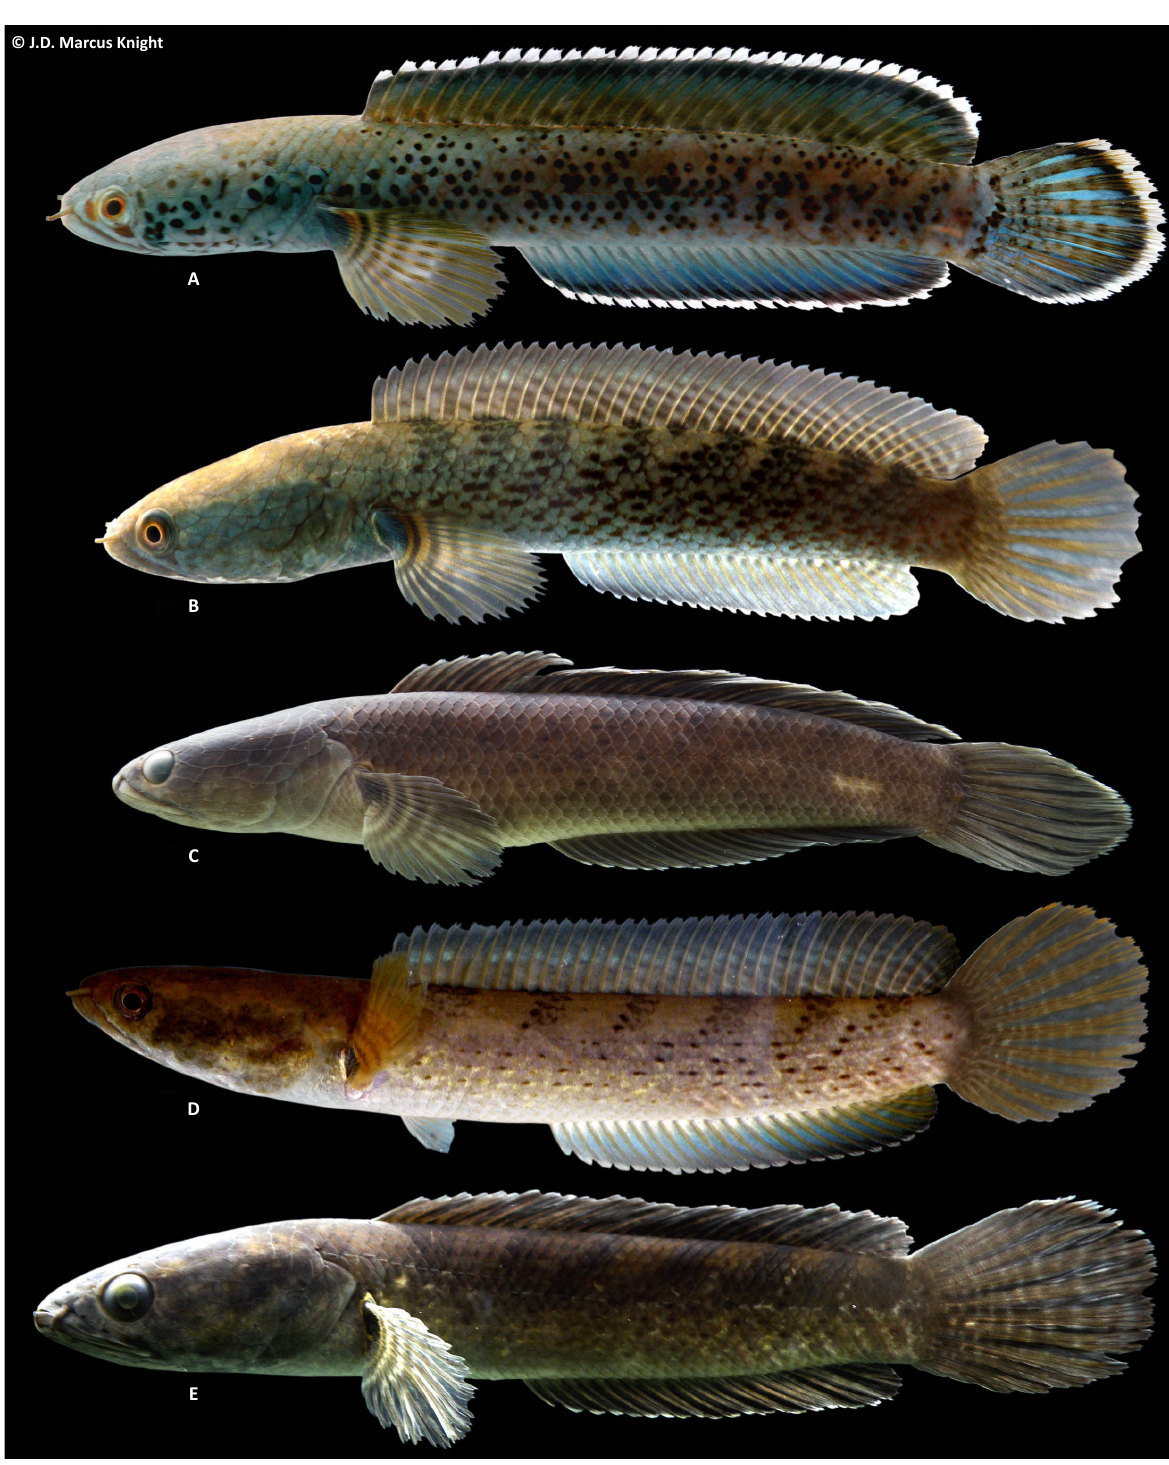
Image 2. Channa pardalis : A, paratype, ZSI/SRC F 8954, 139.3mm SL, showing live colouration, West Khasi Hills, Meghalaya. C. stewartii : MKC 100, Cachar, Assam, B, 109.2mm SL, showing live colouration, C, 128.6mm SL, showing colouration in preservative. C. melanostigma : MKC 012, Tinsukia, Assam, D, 118.1mm SL showing live colouration, E, 122.9mm SL, showing colouration in